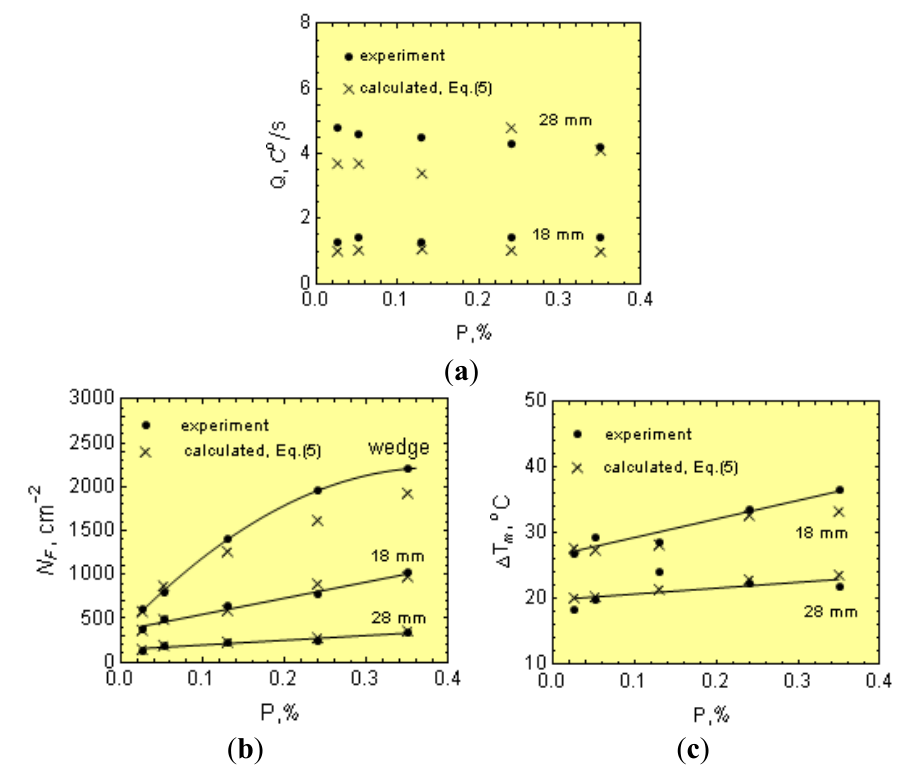
Figure 19. Effect of phosphorous on ( a ) Q , ( b ) N F and ( c ) Δ T m . Table 7. Effect of P on cast iron T i